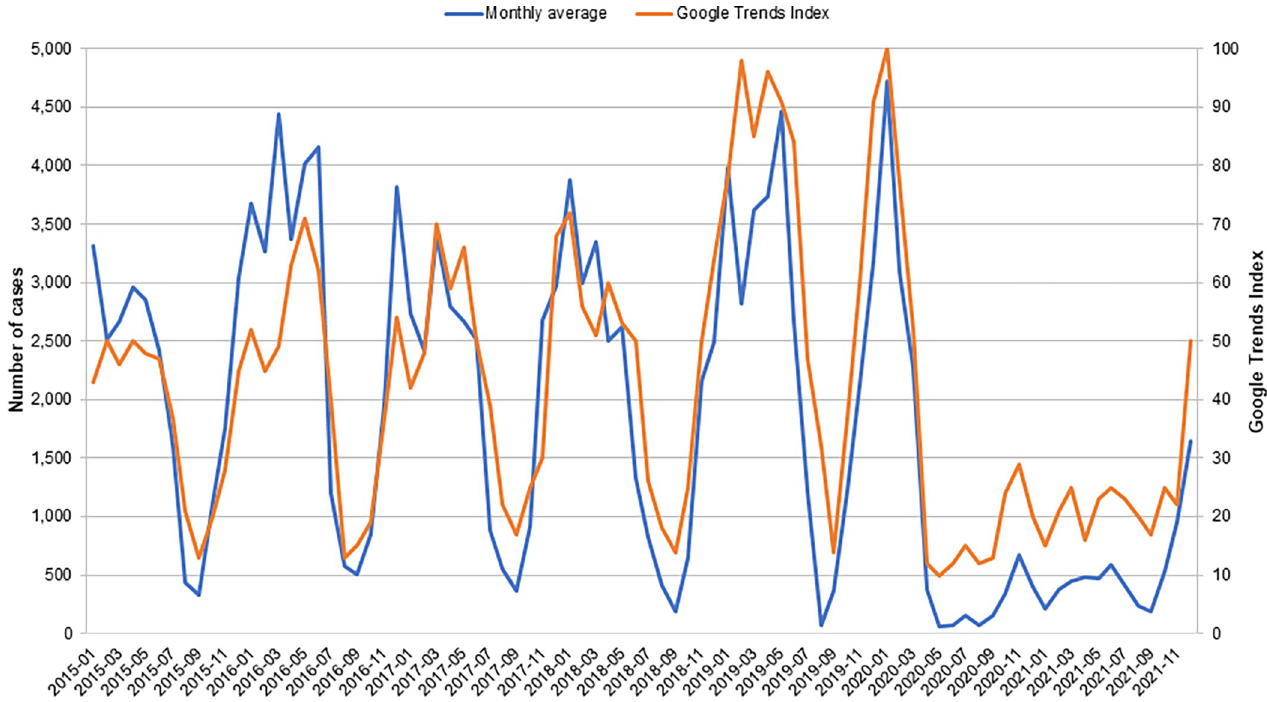
Fig 3. Relative search query popularity of varicella keywords and varicella cases in Bulgaria, January 2015 to December 2021. Monthly varicella case data are based on aggregated weekly case counts reported by the National Center of Infectious and Parasitic Diseases in Bulgaria [22]. The blue line shows these data converted to monthly averages, and the orange line is the Google Trends Index for internet searches performed in each month.